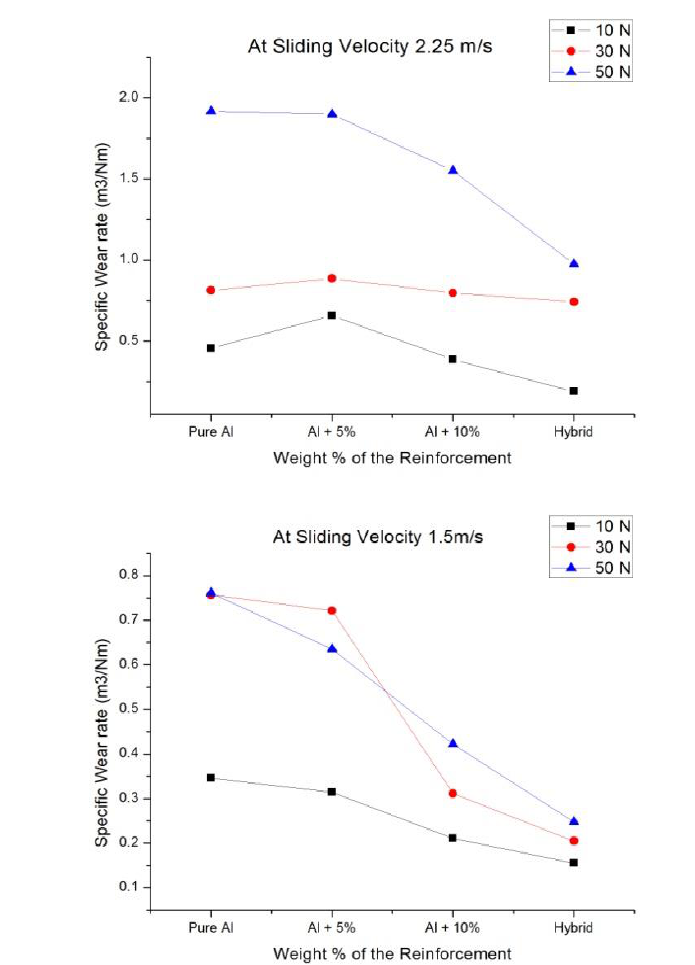
Figure 6. Wear rate of the composites at sliding velocity: ( a ) 0.75 m/s, ( b ) 1.5 m/s ( c ) 2.25 m/s.